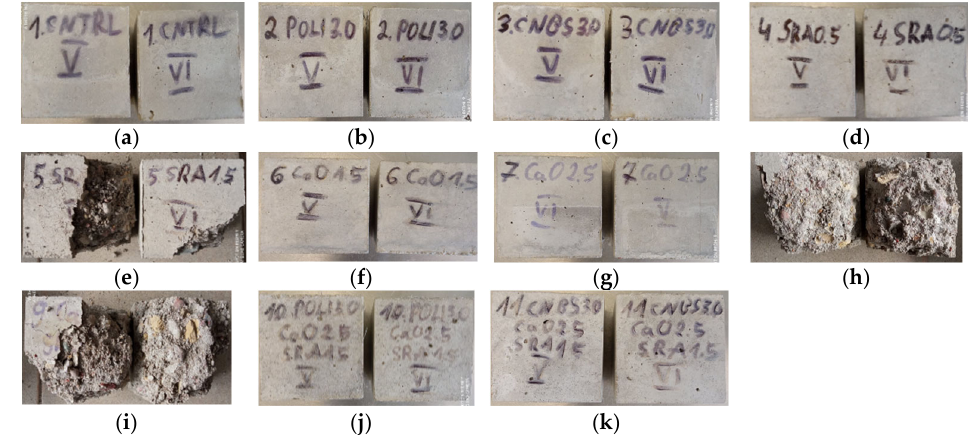
Figure 12. Images of the degradation for concrete specimens after 100 freeze ‐ thaw cycles; ( a ) CNTRL; ( b ) POL3.0; ( c ) CNB3.0; ( d ) SR0.5; ( e ) SR1.5; ( f ) Ca1.5; ( g ) Ca2.5; ( h ) Ca1.5SR1.5; ( i ) Ca2.5SR1.5; ( j ) POL3.0Ca2.5SR1.5; ( k ) CNB3.0Ca2.5SR1.5.